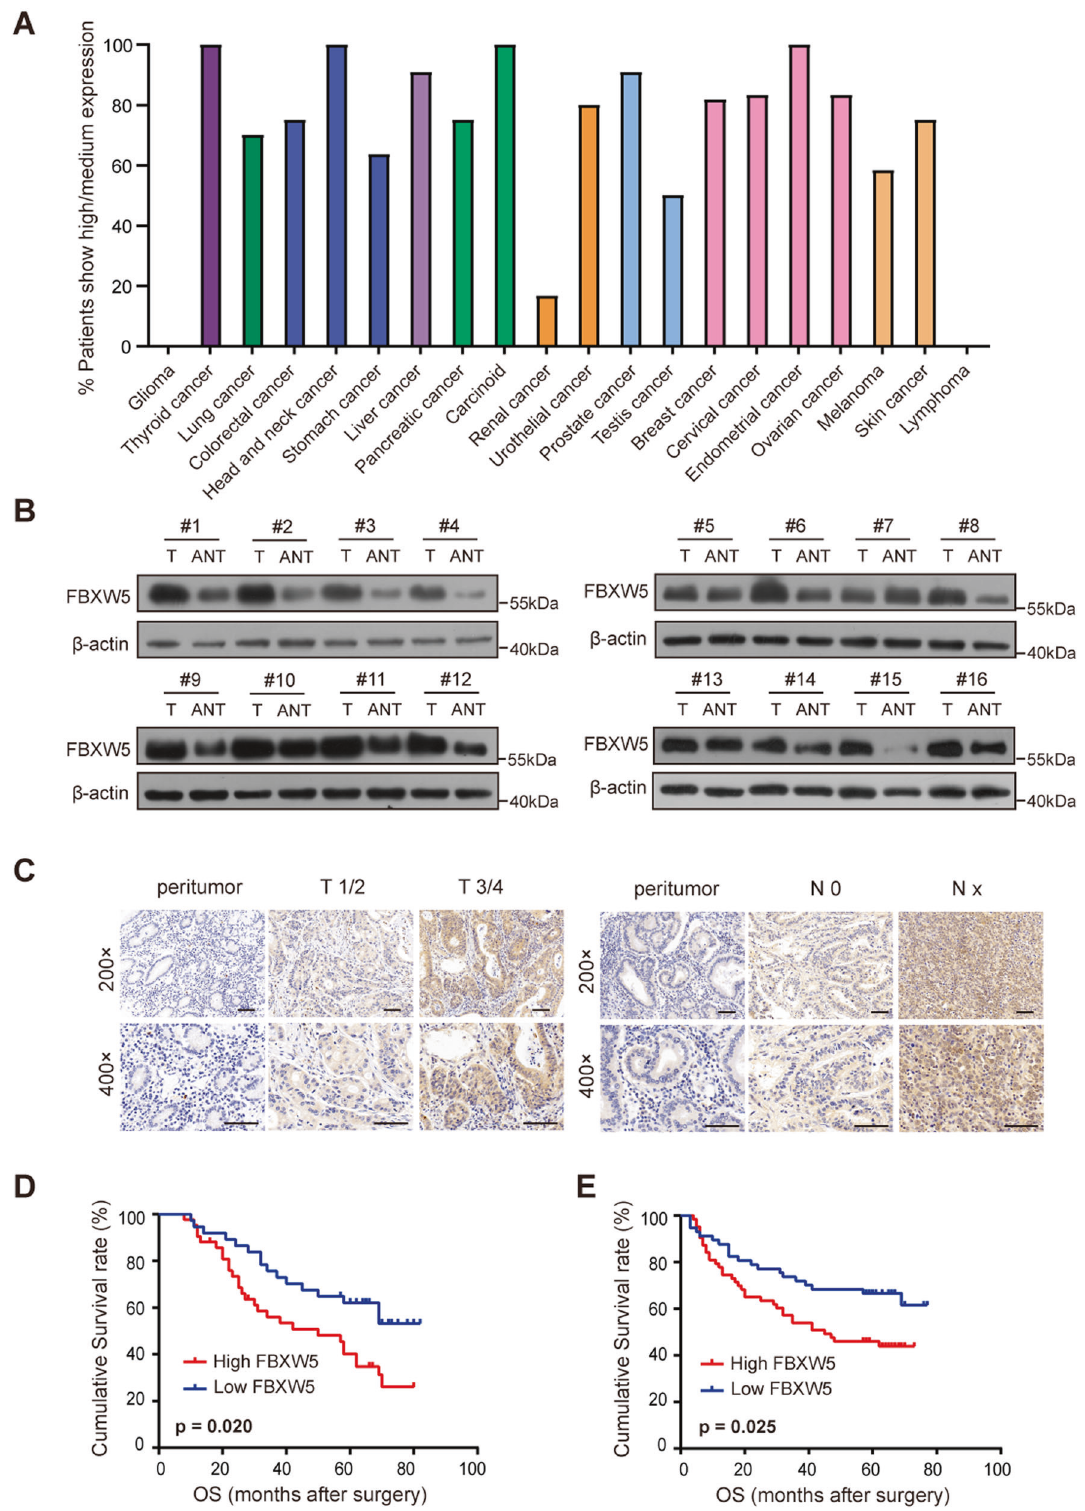
Fig. 1 High FBXW5 expression leads to poor prognosis in patients with GC. A The protein expression of FBXW5 in various cancers is based on the Human Protein Atlas database. B FBXW5 protein level in 16 matched samples of surgically resected gastric tumors and adjacent normal tissues. C Representative IHC images of paraf fi n-embedded gastric tumor tissue specimens. Bar scale: 50 μ m. D Kaplan – Meier survival curves of 79 paraf fi n-embedded GC specimens (high FBXW5 level, n = 42; low FBXW5 level, n = 37; log-rank p = 0.020). E Kaplan – Meier survival curves of 120 paraf fi n-embedded GC specimens in the validation group (high FBXW5 level, n = 63; low FBXW5 level, n = 57; log-rank p = 0.025).